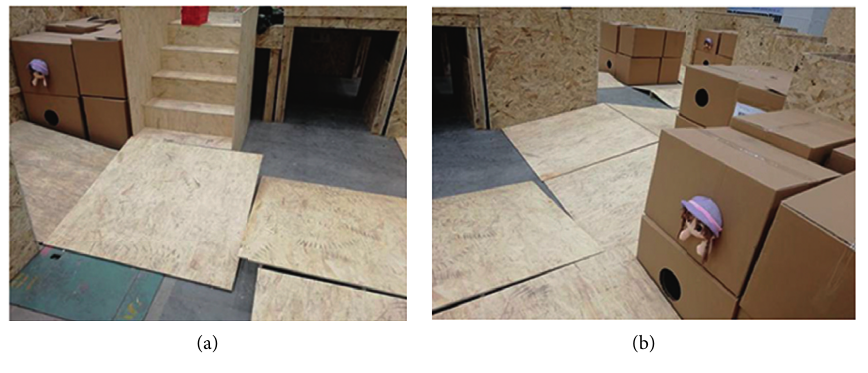
Figure 14: RoboCup venue.